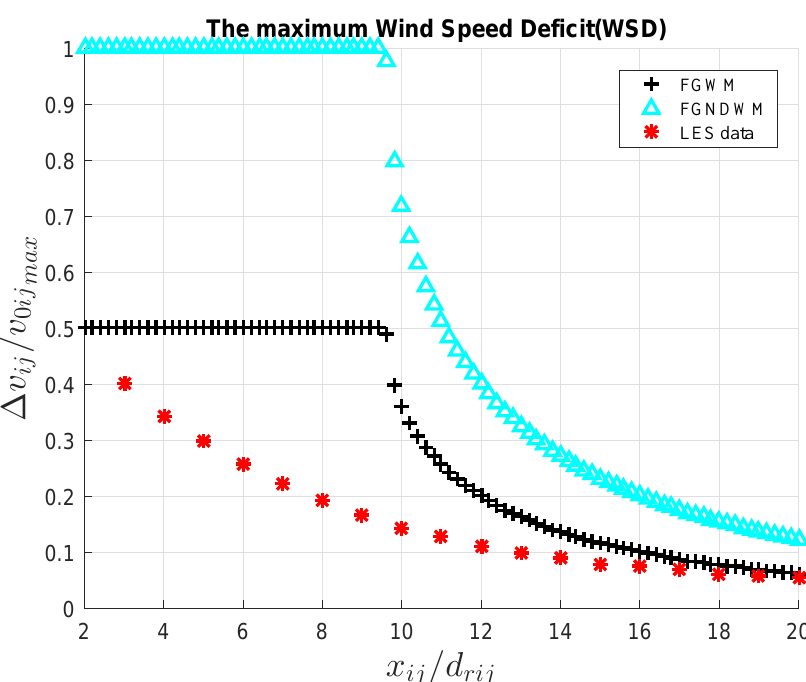
Figure 6. The portrait of the maximum Wind Speed Deficit (WSD) in Case b (fitted by LES data, i = 1,2, · · · , N ; j = 1,2, · · · , N ).